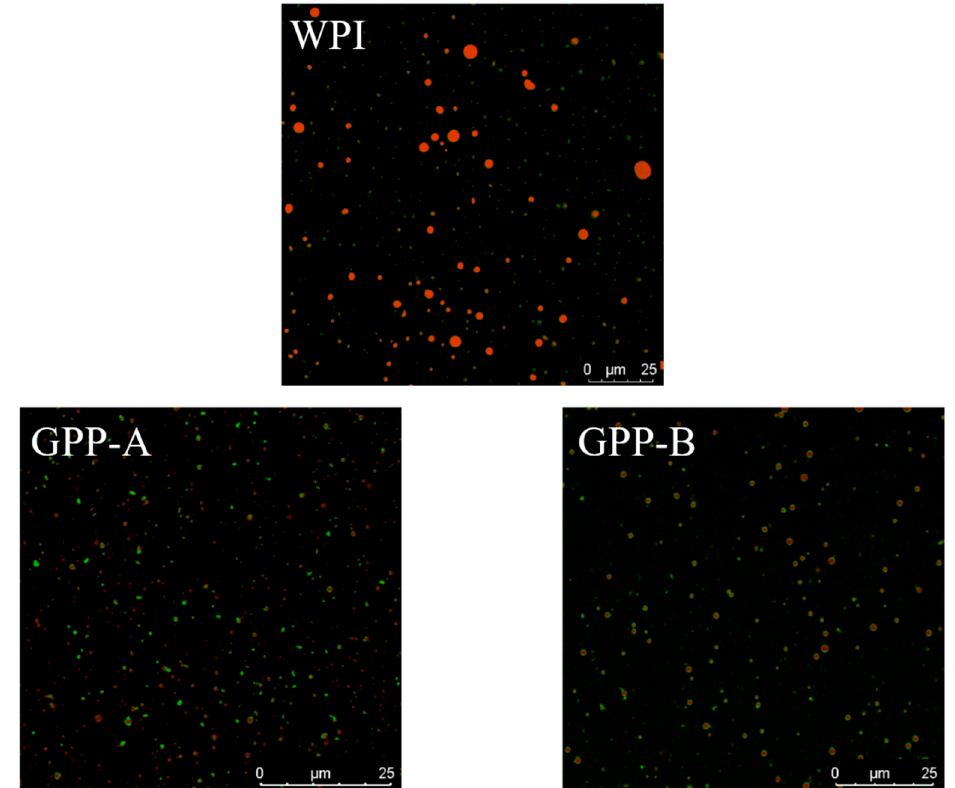
Figure 5. Changes in micrographs by using confocal laser scanning microscopy (CLSM) of CLA emulsions stabilized by GPP-A and GPP-B. All of the images were obtained with the Nile blue fluorescent dye. Magnification 40× and bar represent 50 μ m in length.